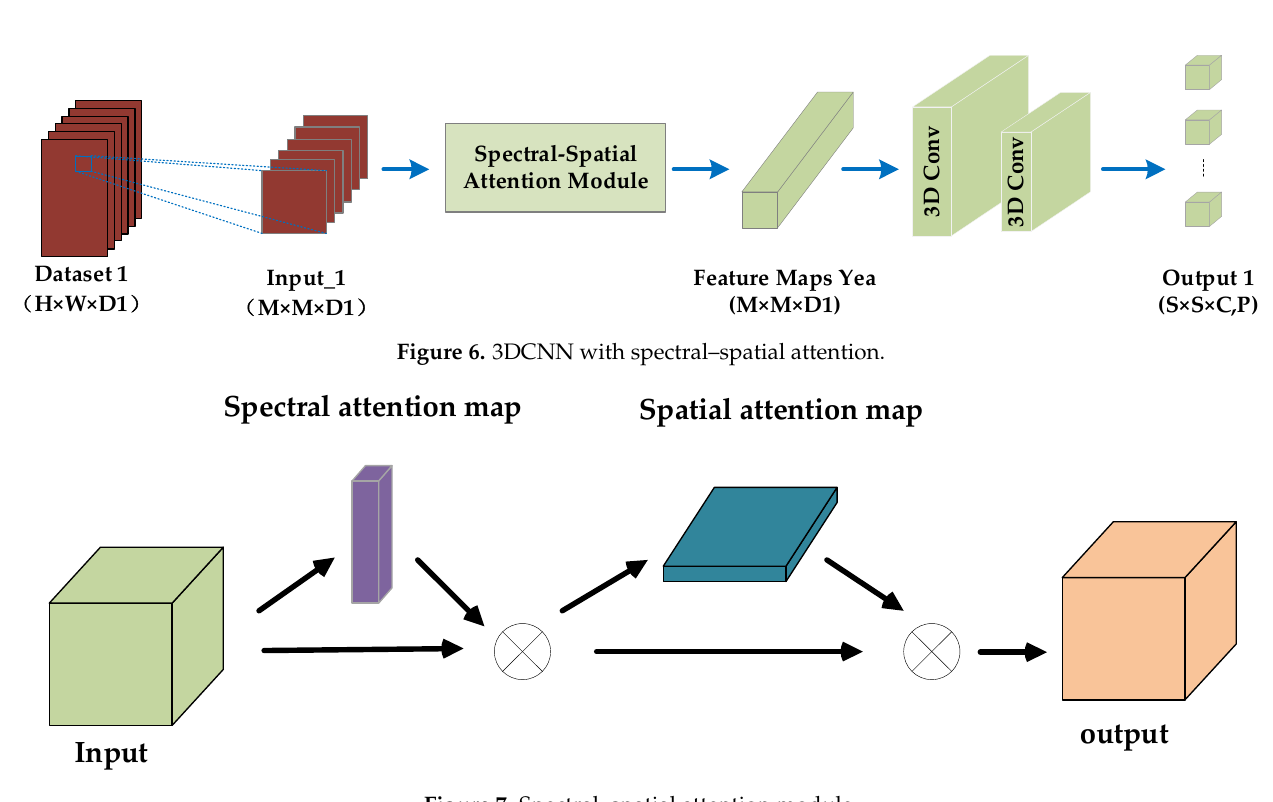
Figure 7. Spectral–spatial attention module.